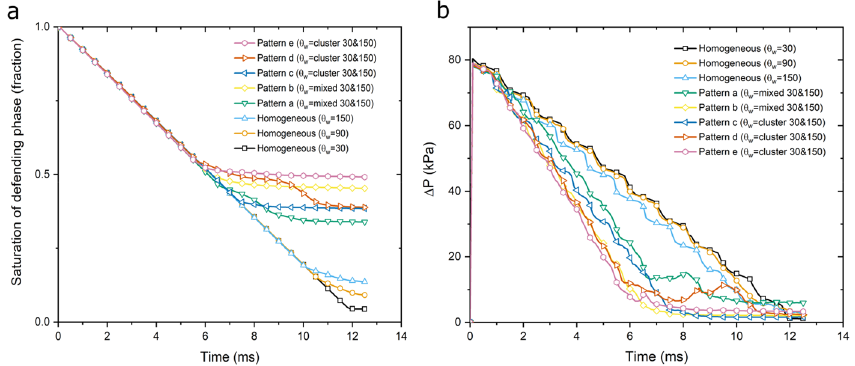
Figure 8. ( a ) Saturation of the defending phase and ( b ) Pressure drop (kPa) across the porous medium for all simulation cases (homogeneous and heterogenous wettability patterns) during displacement at log Ca = − 4 and log M = −